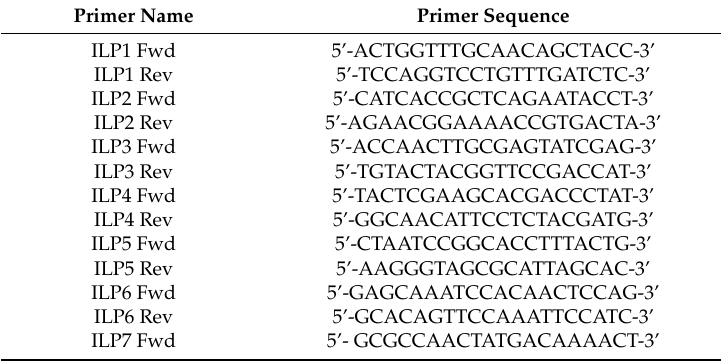
Table 1. Primer sequences for real-time RT-PCR. Sequences for all insulin-like peptides (ILPs), insulin receptor, and the housekeeping gene, ribosomal protein S7, are listed